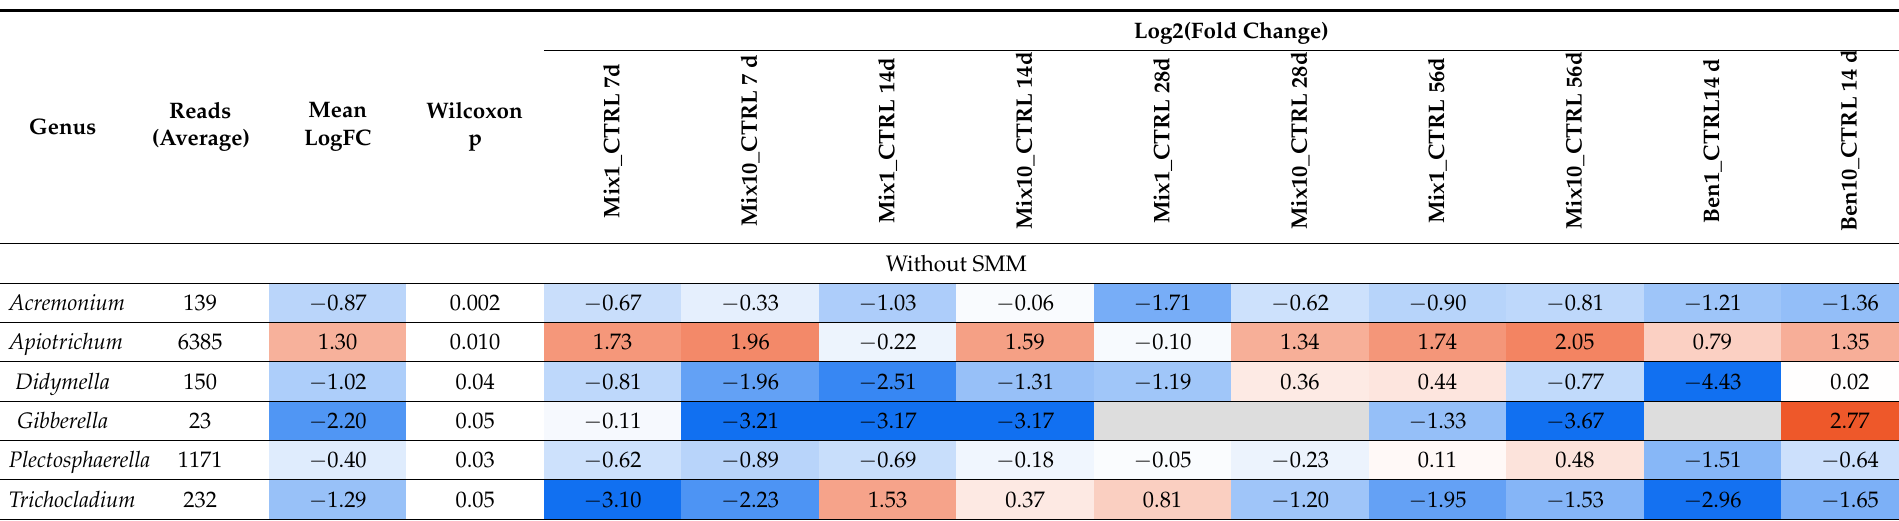
Table 10. Paired comparison of abundances of various fungal genera between control and treated soil